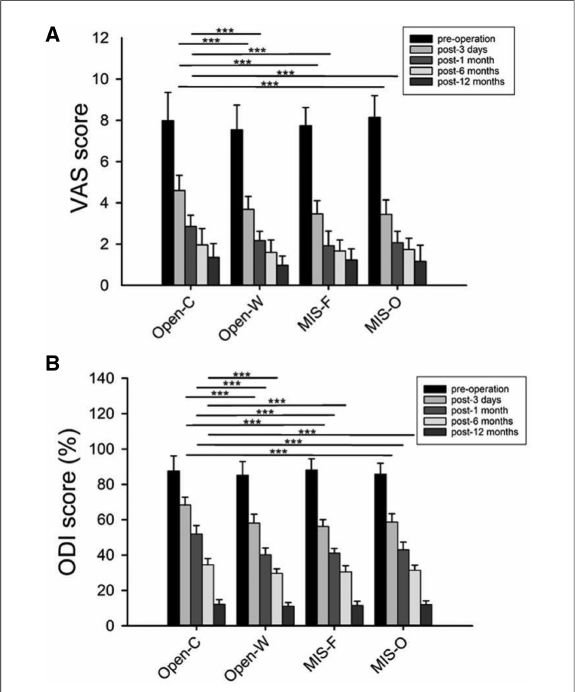
FIGURE 3 Comparison of VAS and ODI scores before operation and at different follow-up times among the four groups. Comparison of VAS ( A ) and ODI ( B ) scores before operation and at different follow-up times among the four groups. VAS, Visual Analogue Scale; ODI, Oswestry Disability Index; Open-C, conventional open approach; Open-W, Wiltse approach; MIS-F, percutaneous approach with fl uoroscopy guidance; MIS-O, percutaneous approach with O-arm navigation. * P <0.05; ** P <0.01; *** P